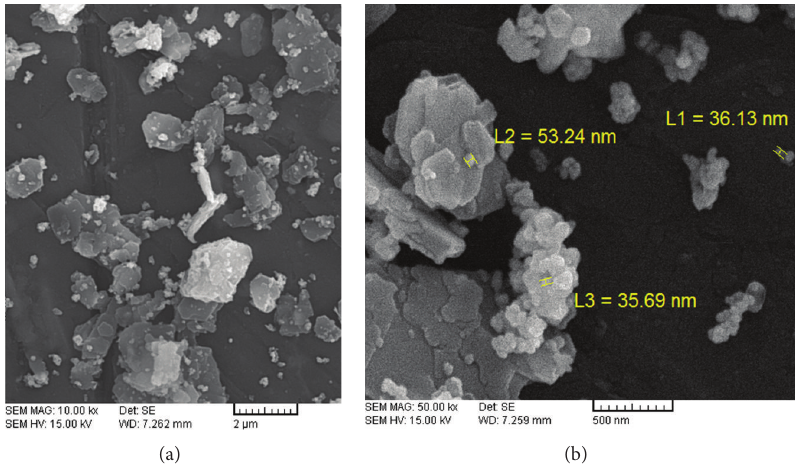
Figure 3: SEM images of Kaolin/Ag nanocomposite.